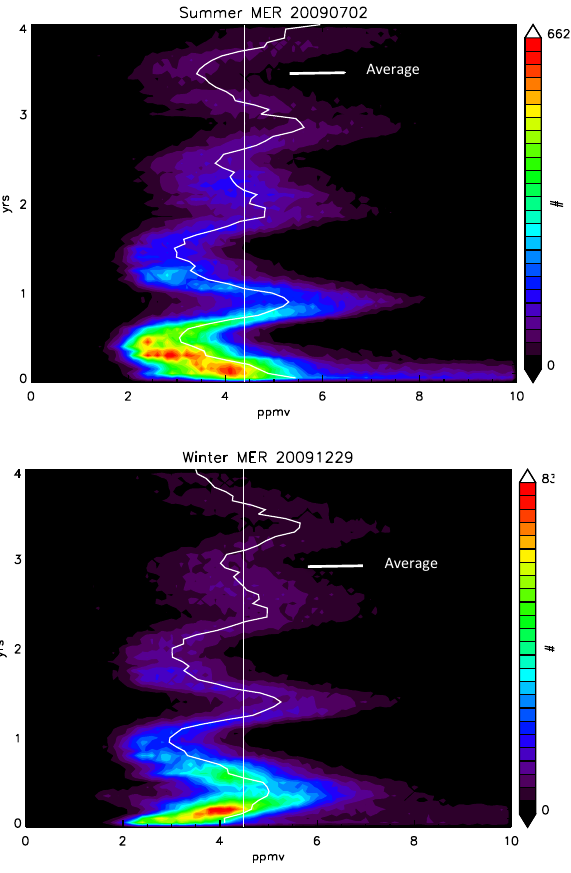
Fig. 5. Water vapor histogram using parcel age vs. water amount for the entire model domain above 18km. The seasonal oscillation in water vapor distribution is evident. As parcels age they may exit the stratosphere leading fewer parcels in the upper part of the plot. Units number of parcels per bin, 0.1ppmv bin size for water; 0.05 year bin size for age.